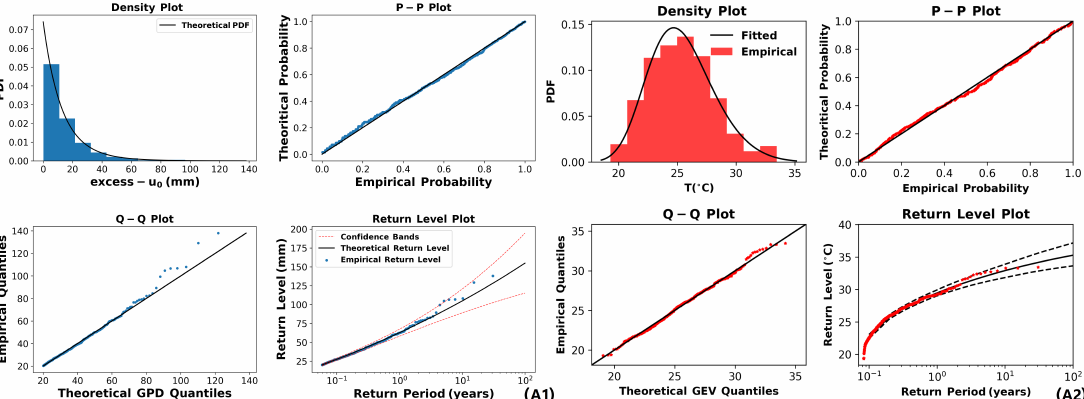
Figure A2. Diagnostic plot for Montalto Uffugo station. ( A1 ) Rainfall diagnostic plot. ( A2 ) tempera- ture diagnostic plot.